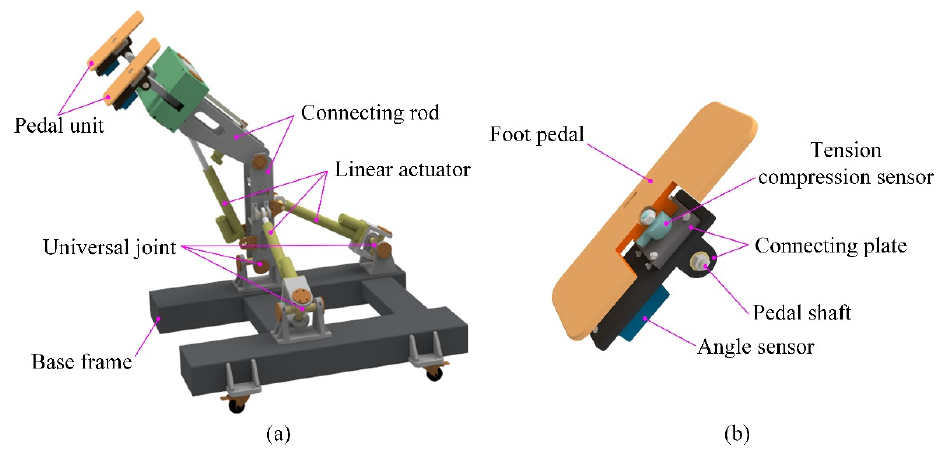
Figure 1. ( a ) The virtual prototype of the HE-LRR; ( b ) structure of pedal